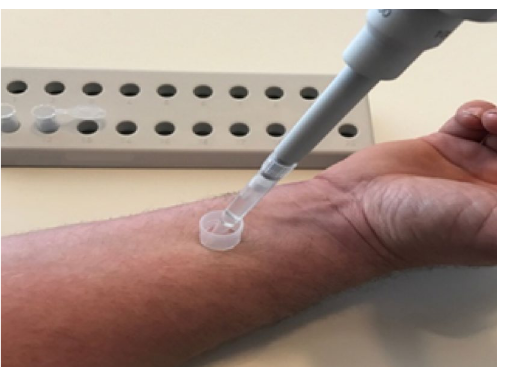
Figure 2. Sample collections from the inner side of the forearm (distal collection is shown); solvent is added and